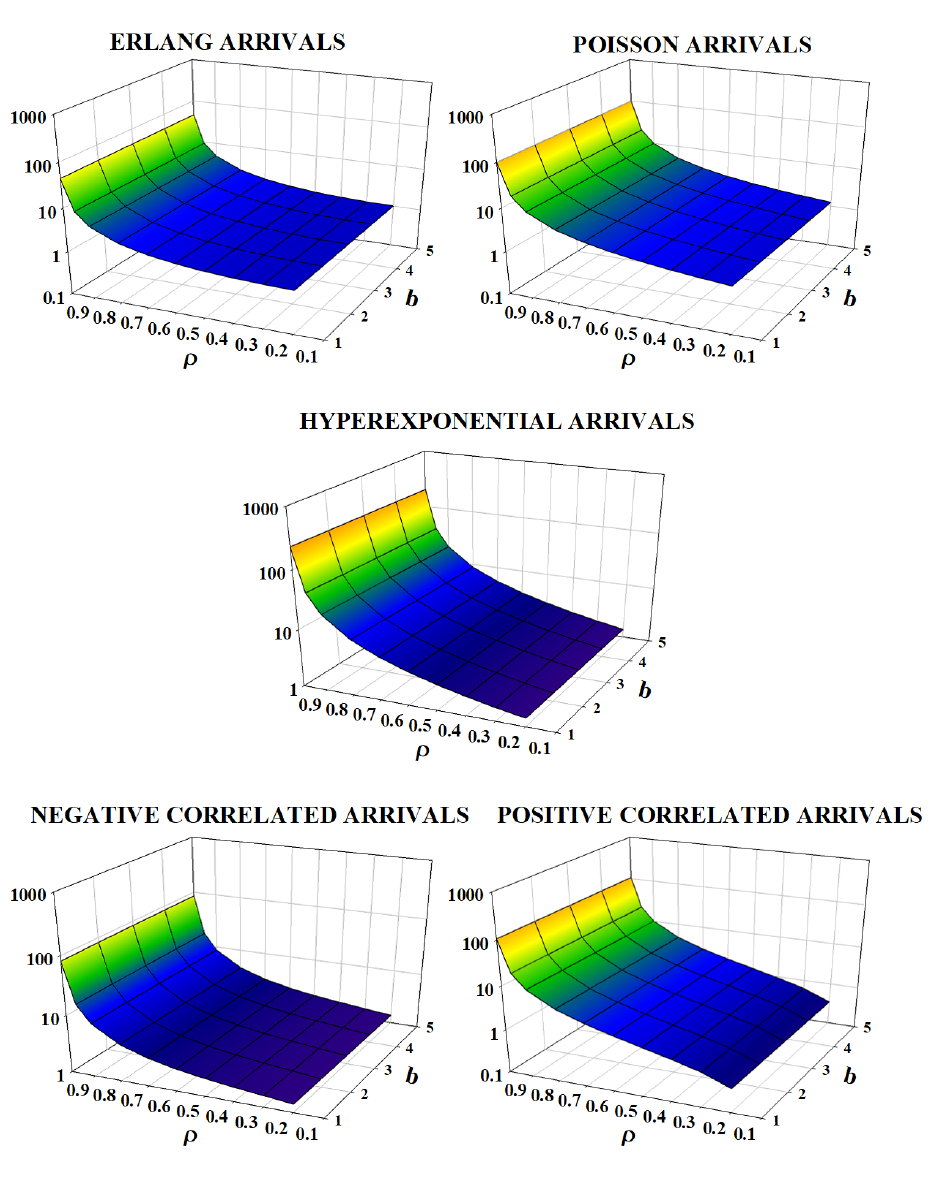
Figure 4. Mean recurrence time ( µ (cid:48)